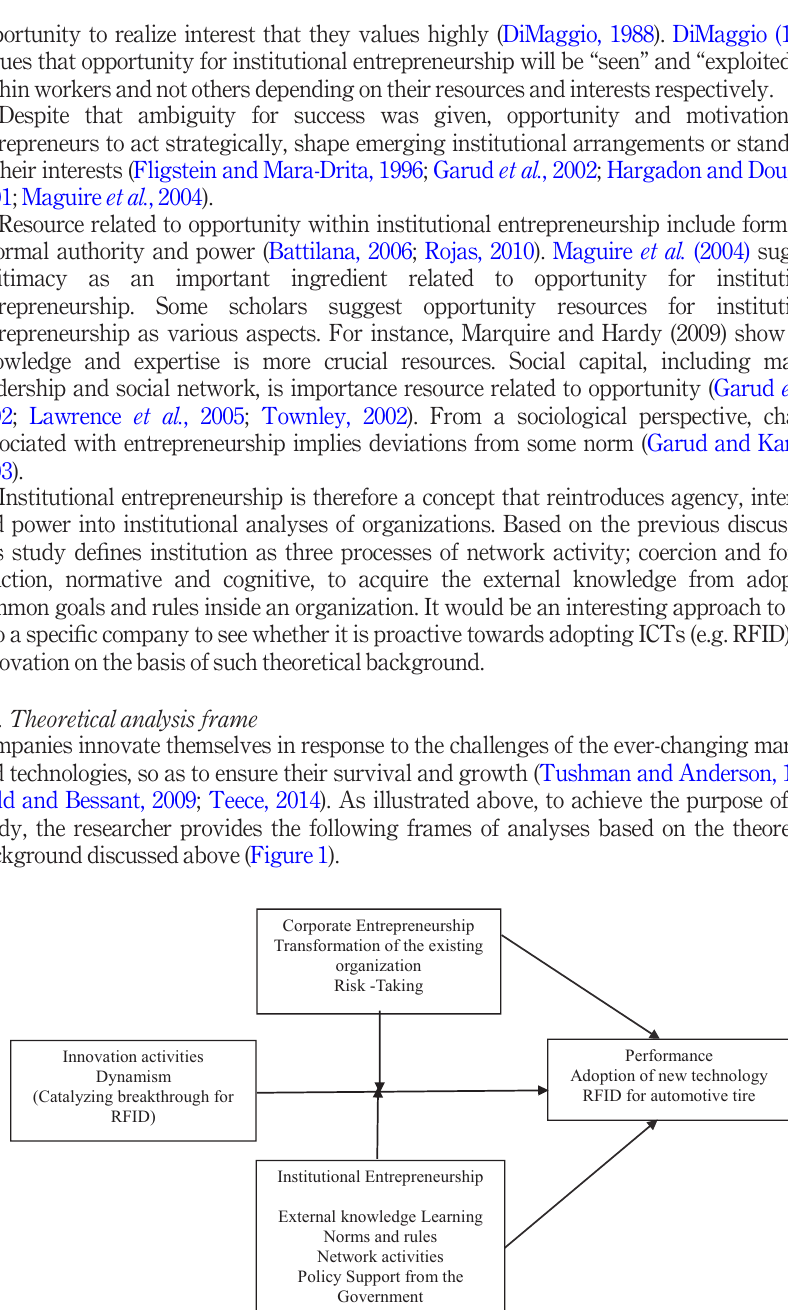
Figure 1. Integrated frame of